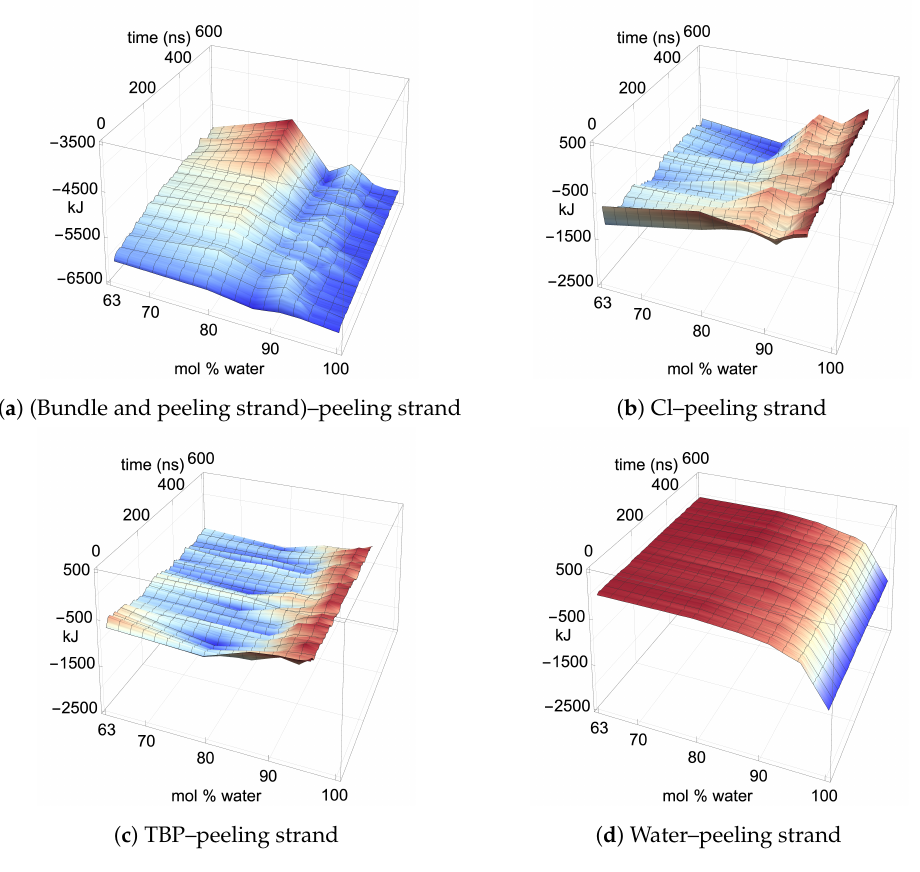
Figure A11. The pairwise energies for the second yellow separating strand at 360K. The pairwise energies are shown between the following: ( a ) (bundle–peeling strand and peeling strand)–peeling strand (i.e., within the strand and with the rest of the cellulose bundle); ( b ) Cl–peeling strand; ( c ) TBP–peeling strand; ( d ) water–peeling strand. These data represent the second yellow strand to peel or the non-peeling yellow strand if the second yellow strand does not peel in the simulation. The data were averaged over 1000 data points, using a rolling average. Every 100th point was then plotted to maintain plot clarity [64].